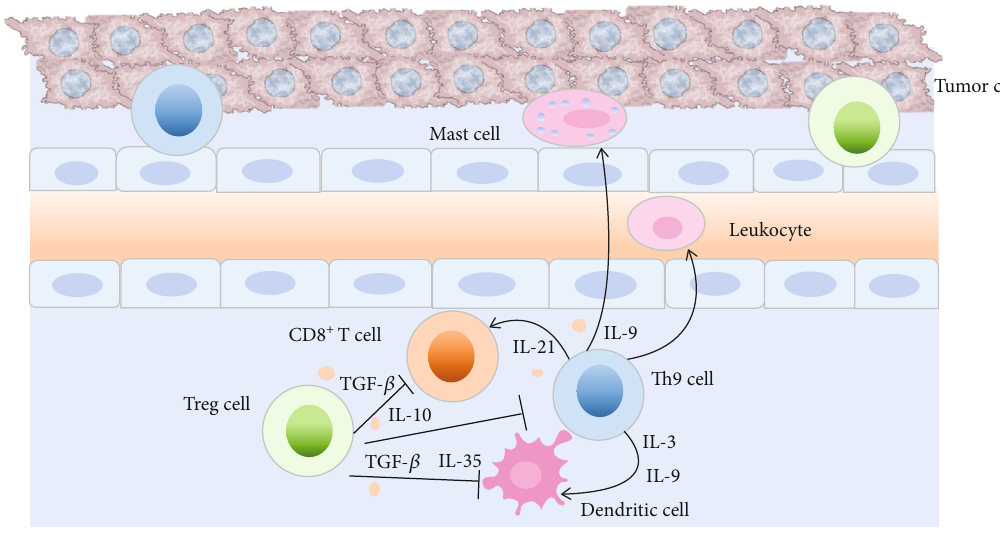
Figure 5: Th9 cells and Treg cells in cancer. The mechanisms underlying the antitumor e ff ects of Th9 cells seem to be mainly dependent on the secretion of IL-9, IL-21, and IL-3 and activation of di ff erent types of immune cells such as MCs, DCs, and CD8 + T cells. IL-9 can induce recruitment of DCs and leukocytes. Then, DCs activate CD8 + T cells through the crosspresentation of tumor antigens, which facilitates tumor rejection. IL-3 and IL-21 have also been shown to promote survival of DCs and enhance response of CD8 + T cells. Production of TGF- β , IL-10, and IL-35 by Treg cells prevents full cytotoxic e ff ector di ff erentiation in tumor-speci fi c CD8 + T cells and suppresses Te ff cells such as Th9 cell di ff erentiation and function. Treg cells that expand during tumor progression contribute to the immune tolerance of cancer by impeding the ability of DCs to orchestrate immune